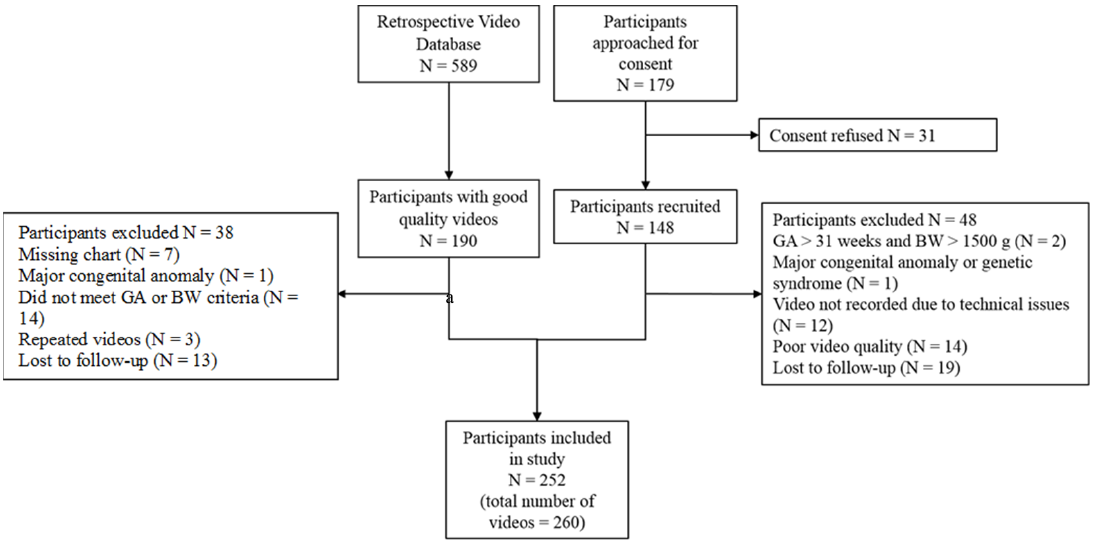
Figure 1. Flow diagram of study population. These videos were included in the analysis.